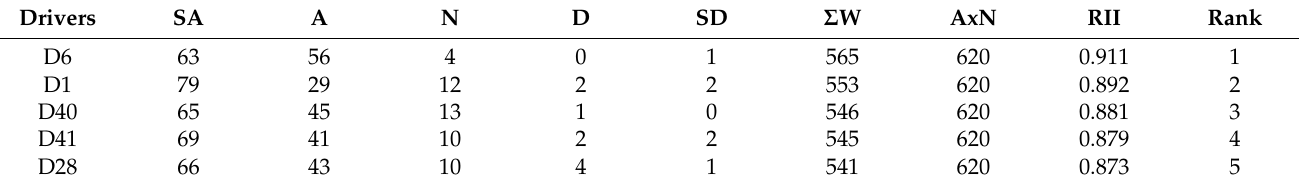
Table 6. Top 5 drivers as per